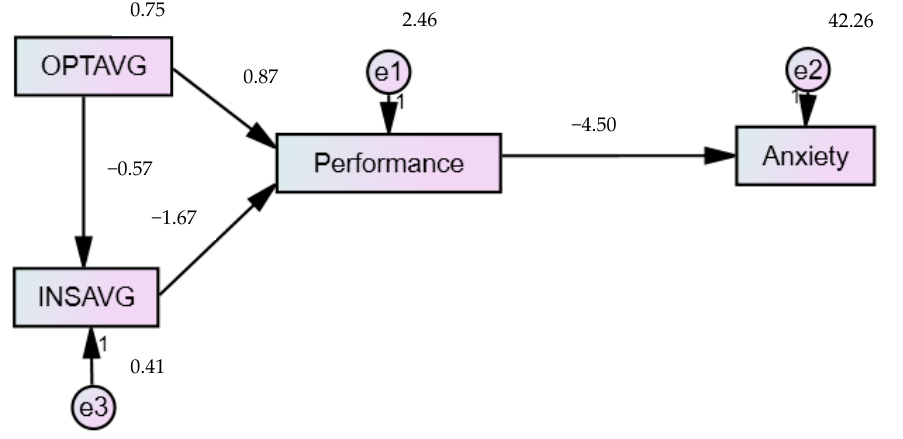
Figure 7. The resulting path models.